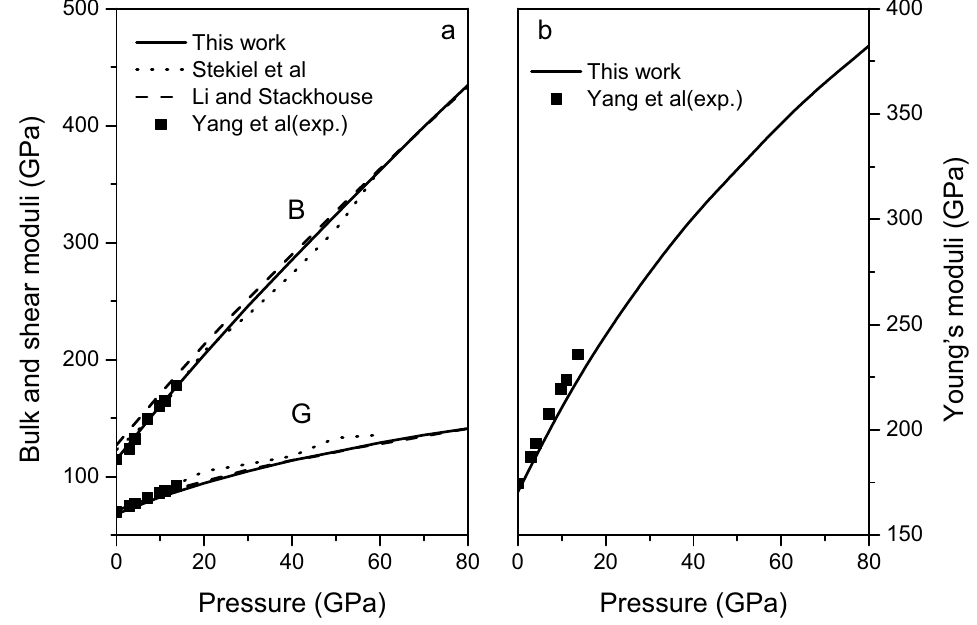
Figure 4. Bulk modulus B , shear modulus G ( a ) and Young’s modulus E ( b ) of magnesite from 0 to 80